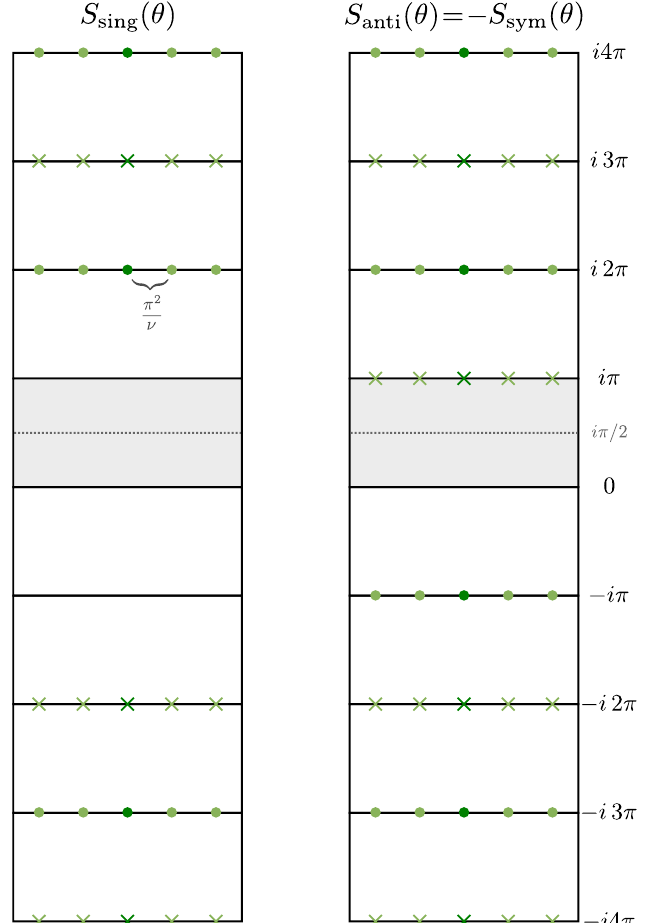
Figure 15 . Analytic structure of the solution to the maximization of the singlet representation S sing ( i(cid:25)= 2) without bound states presented in (4.20). The anti-symmetric and symmetric represen- tations are the same up to a minus sign. The horizontal spacing between zeros and poles is (cid:25) 2 =(cid:23)